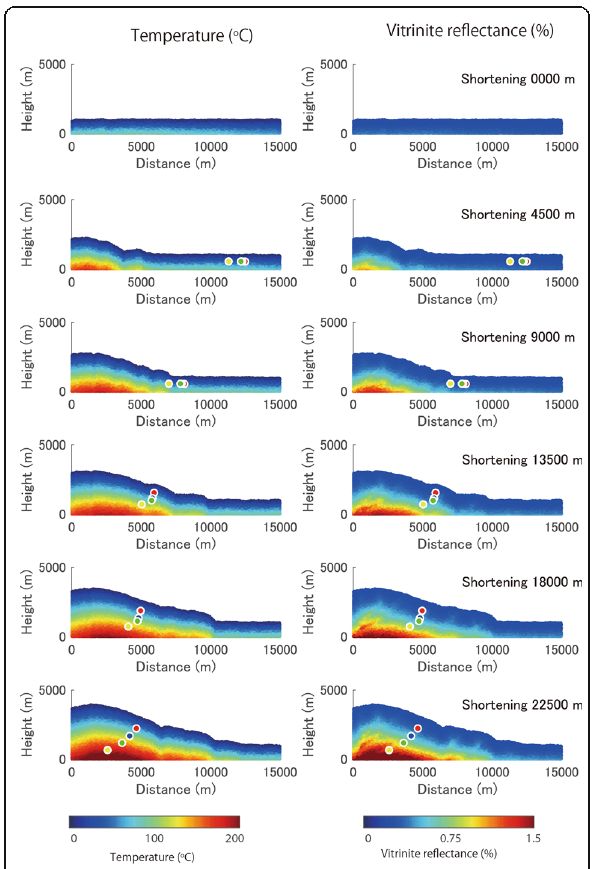
Fig. 6 The geological and the thermal maturity structure after 22,500 m of the total shortening. The geological structure ( a ). The thermal maturity structure as the vitrinite reflectance structure ( b ). The horizontal profiles of the vitrinite reflectance ( c ). The vertical profiles of the vitrinite reflectance ( d ). The position of the profile lines is displayed on the geological structure and the thermal maturity structure. The solid black lines in a and white lines in b are fore thrust, and the broken black lines in a and white lines in b are back thrust. The thick slid black line in a and white line in b depict the OOST. The gray shades in c and d depict position of the faults crossing the profile